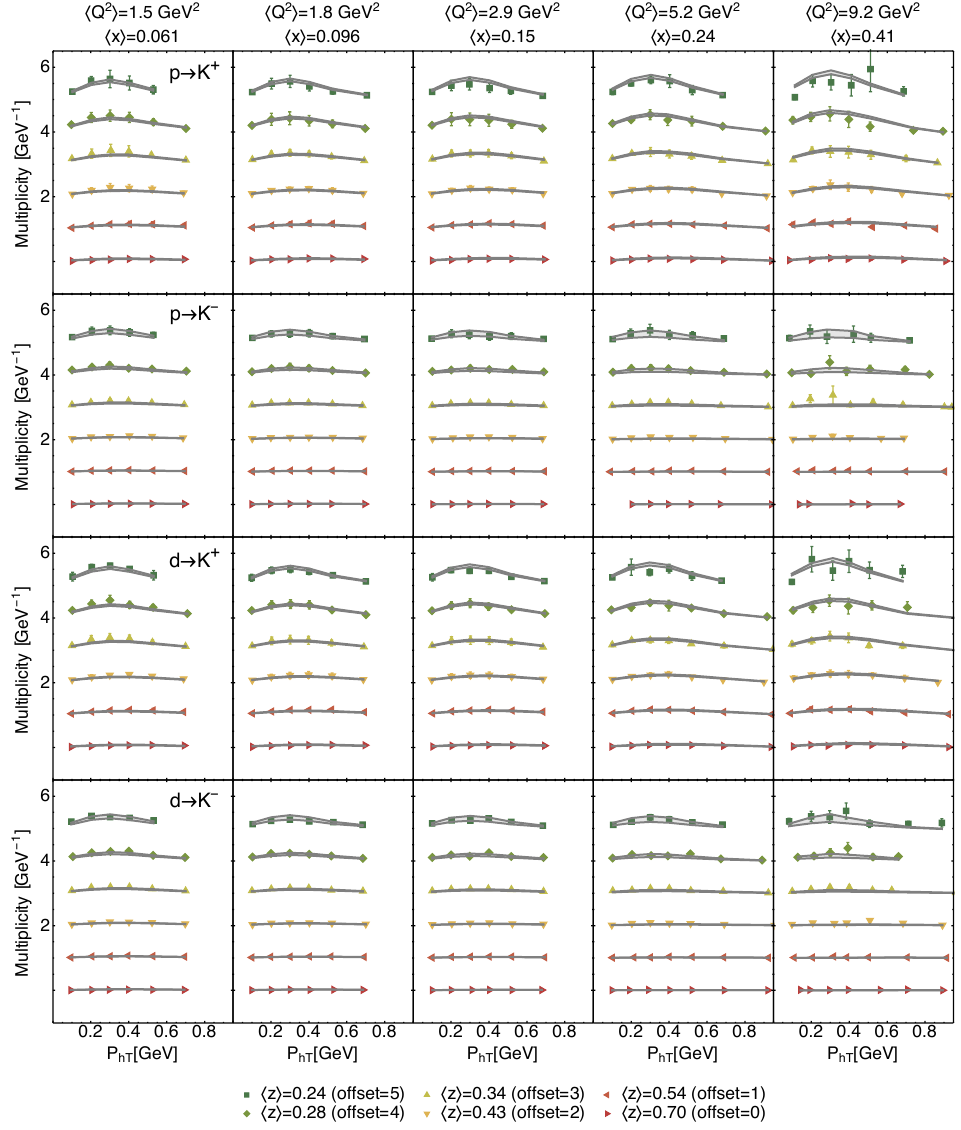
Figure 4 . Hermes multiplicities for production of kaons off a proton and a deuteron for different x , z , and Q 2 bins as a function of the transverse momentum of the detected hadron P hT . For h i h i h i clarity, each z bin has been shifted by an offset indicated in the h i